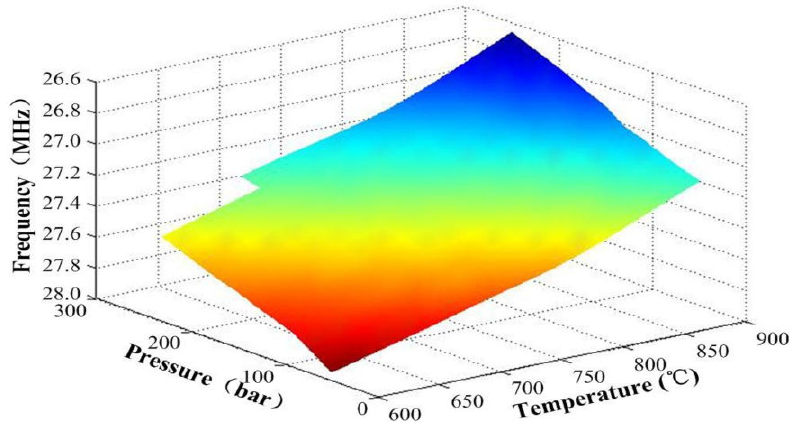
Figure 7. Resonant frequency of the sensor as a function of pressure and